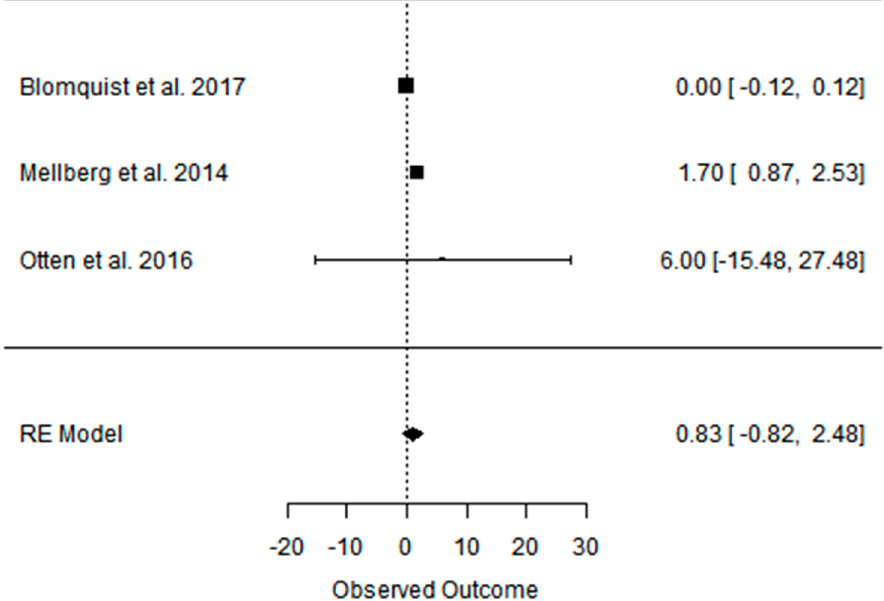
Figure A41. Forest plot of the effect of a CD on SBP in the long term (weighted mean difference).